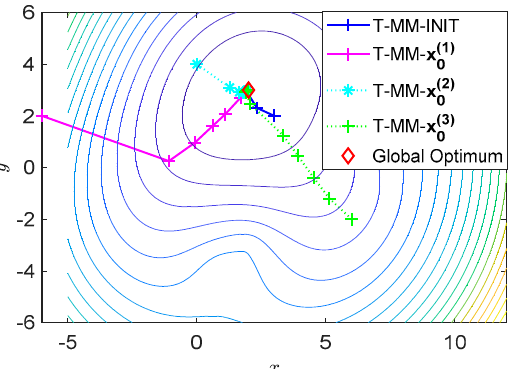
Figure 6. Start with four different initial points. True position of target is 𝑥 = (2,3) . Initial points calculated by the initial gradient algorithm is T-MM-INIT. The randomly selected initial points are 𝑥 (cid:2868)((cid:2869)) = (−6,2) , 𝑥 (cid:2868)((cid:2870)) = (0,4) , 𝑥 (cid:2868)((cid:2871)) = (6,−2) .